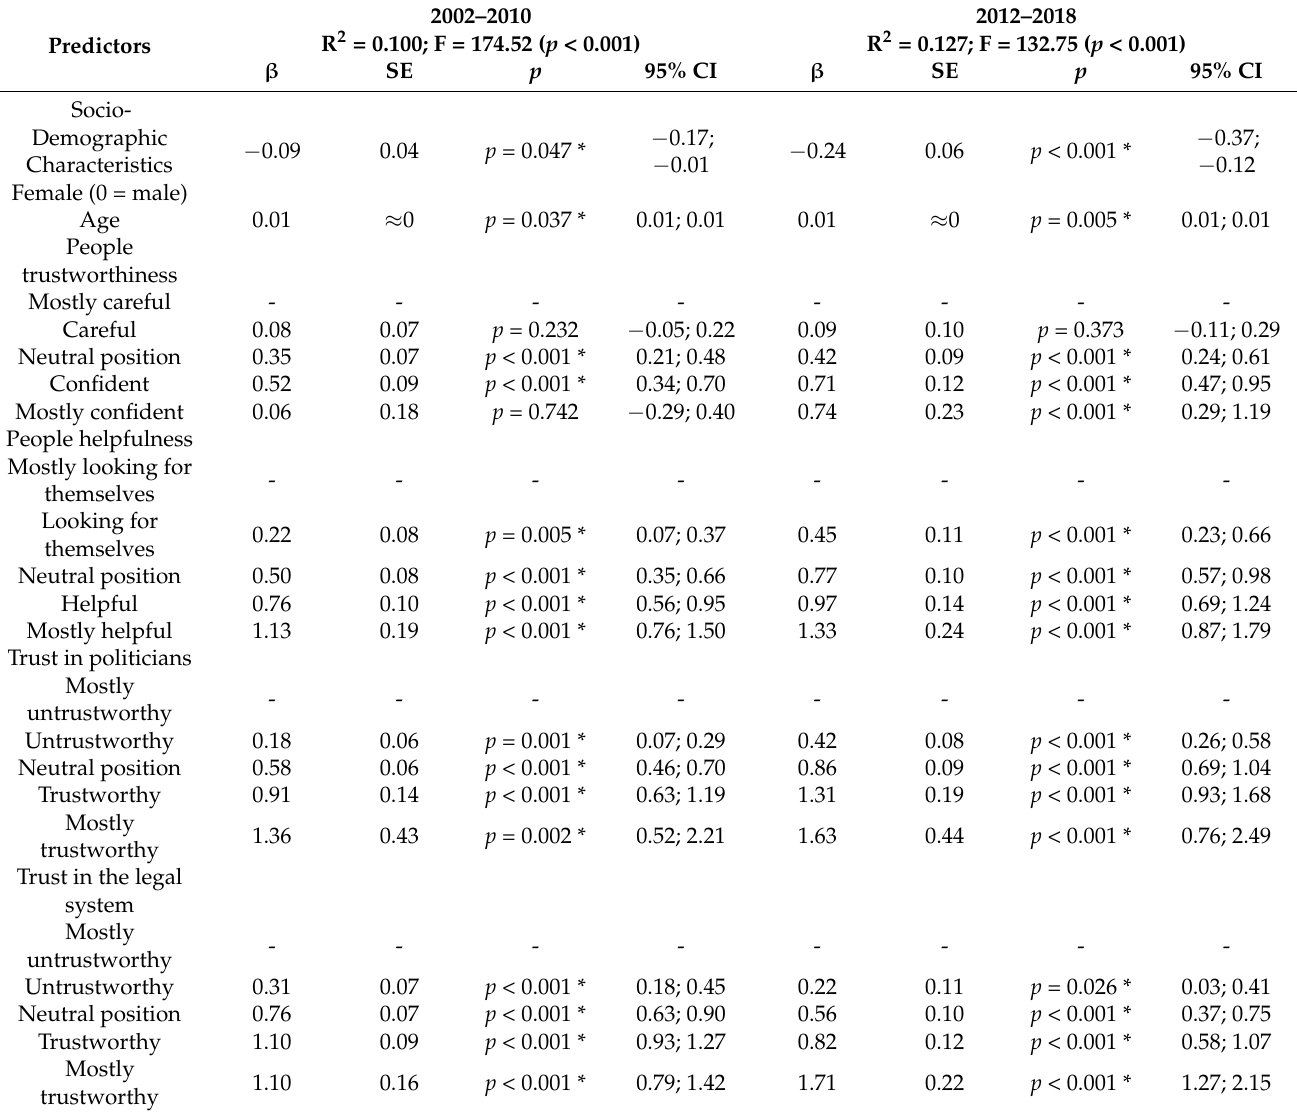
Table 7. Model 4—social